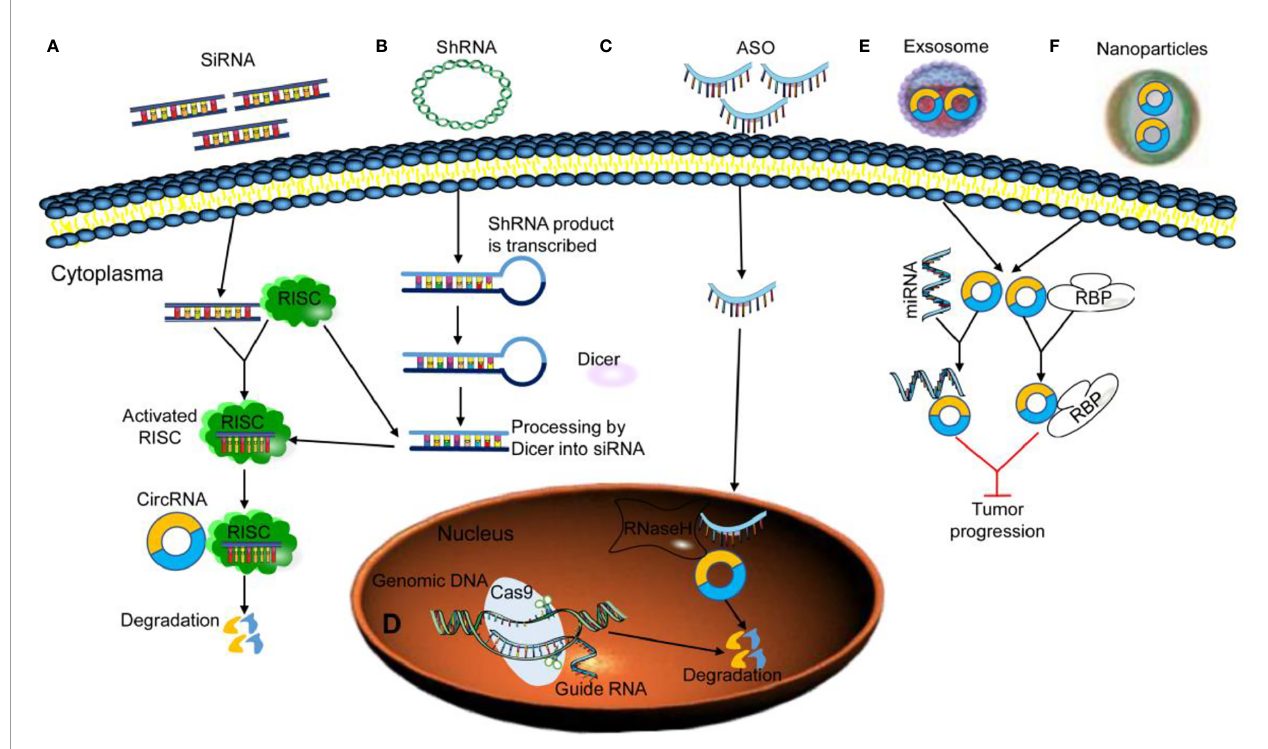
FIGURE 3 | Strategies for targeting circRNAs. (A, B) Exogenous siRNA/shRNA activates RNA-induced silencing complex (RISC) and interacts with its speci fi c target circRNA to induce degradation. (C) Exogenous antisense oligodeoxynucleotide (ASO) activates RNase H to induce circRNA to degradation. (D) Knockout of circRNA- associated genomic DNA using clustered regularly interspaced short palindromic repeats (CRISPR)/Cas9. (E, F) The loss of speci fi c circRNAs can be rescued by reintroducing exosomal or nanoparticles ’ circRNA into the cells as miRNA or RNA-binding protein (RBP) sponges to inhibit tumor